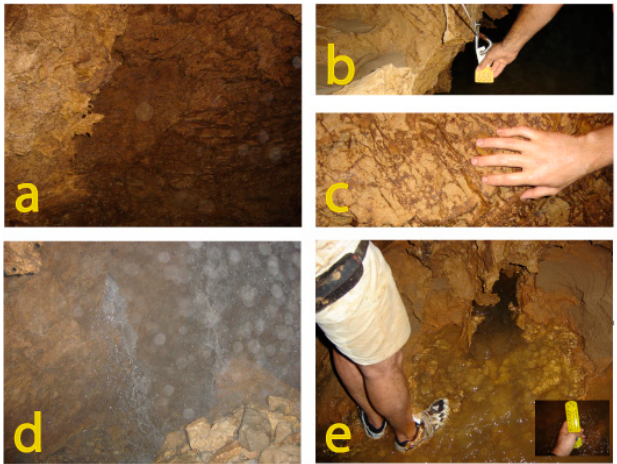
Figure 6. Speleological views of CS chimney. ( a ) CS wall at lifeline mark n° 658 (8 August); ( b ) lifeline mark 658; ( c ) “dry” CS wall at mark n° 658; ( d ) Cascading Hérault intrusion at mark 658 (CS1 in mark 658; ( c ) “dry” CS wall at mark n ◦ 658; ( d ) Cascading Hérault intrusion at mark 658 (CS1